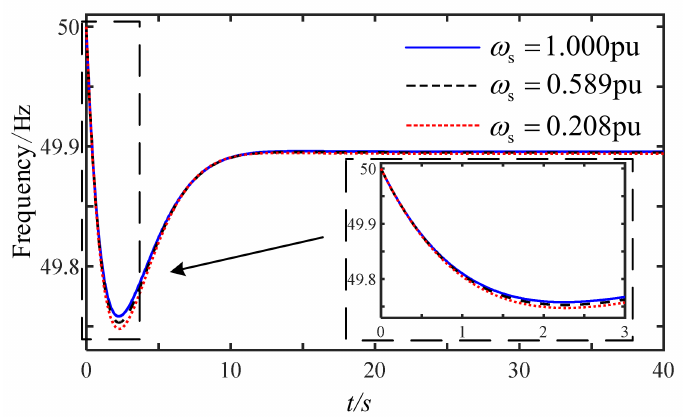
Figure 10. The influence of different operating points on the equivalent inertia of asynchronous motor. It can be seen from the detailed expression of H im (s) that the equivalent inertia is mainly affected by rotor resistance, inertia time constant, and mechanical load coefficient except the operating point. Figure 11 shows the influence of these three parameters on the equivalent inertia of asynchronous motor. In Figure 11, the blue line indicates R r = 1.812 pu, H = 1.5 s, and P 0 = 0.5. The black line indicates R r = 0.3624 pu, H = 1.5 s, and P 0 = 0.5. The red line indicates R r = 0.3624 pu, H = 7.5 s, and P 0 = 0.5. The purple line indicates R r = 0.3624 pu, H = 7.5 s, and P 0 = 2.5. It can be seen from the figure that the maximum rate of change of frequency, the maximum frequency deviation, and the steady-state frequency deviation decrease with the decrease in rotor resistance. The maximum rate of change of frequency and the maximum frequency deviation decrease with the increase in inertia time constant.